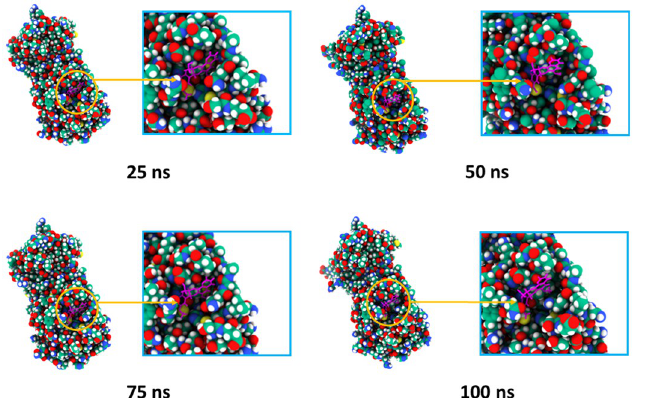
Fig 6. Surface view of the docked Cleomiscosin A and Mpro complex, where snapshots at 25, 50, 75, and 100 ns were acquired.